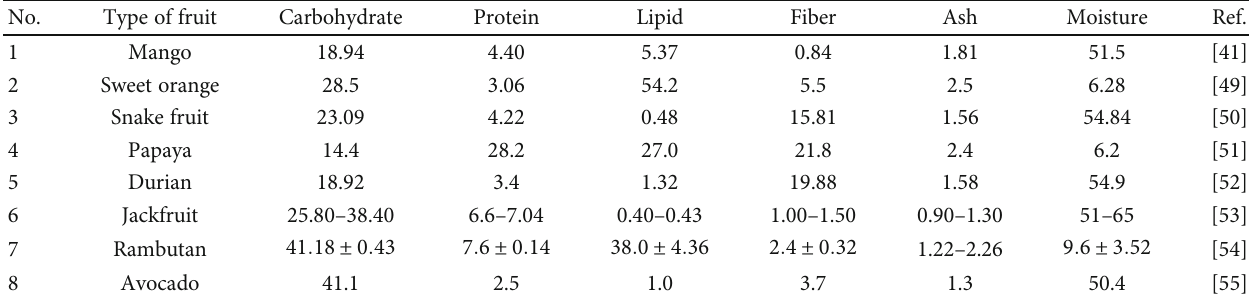
Table 3: The nutritional content of the kernel seed of Indonesian exotic fruits (% w / w